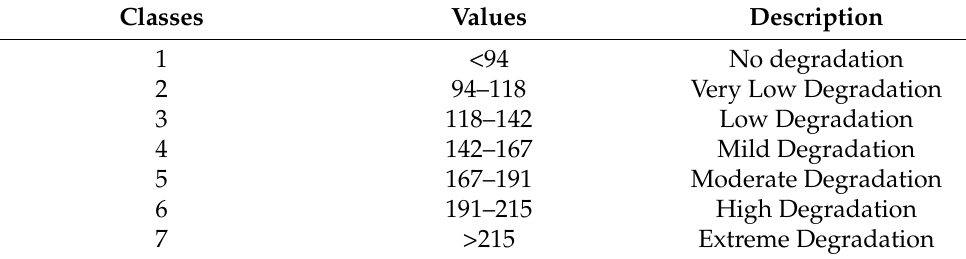
Table 4. WLDI scaled values of degradation degree